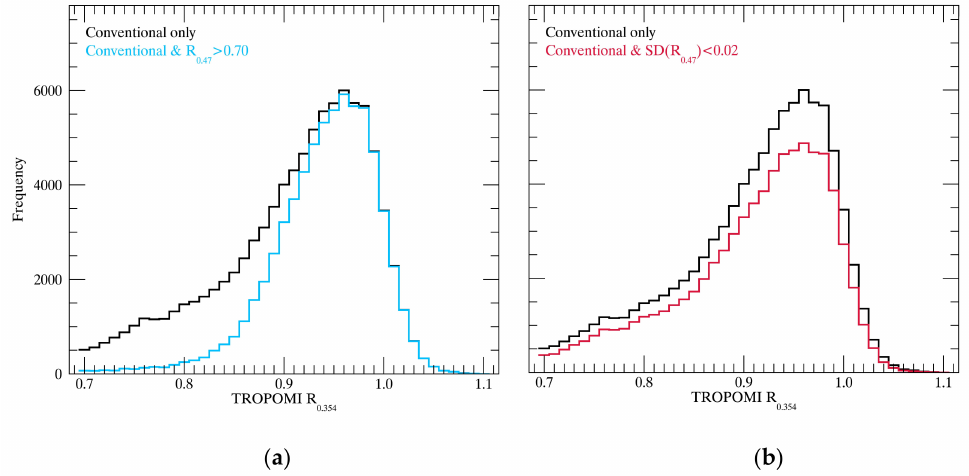
Figure 11. Frequency distribution of TROPOMI R 354 with an additional AHI R 0.47 restriction for data from July 2018–June 2019 taken at five-day intervals.